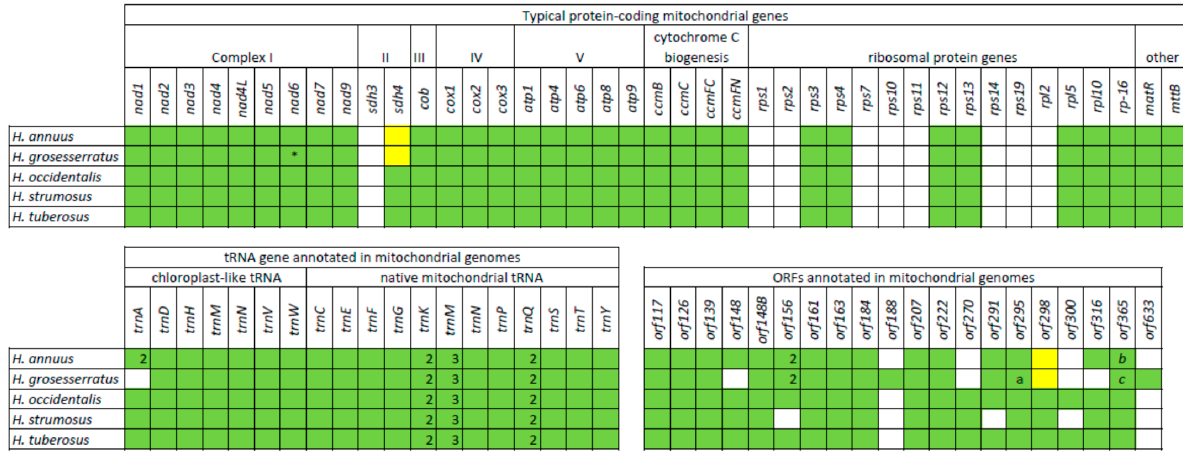
Figure 3. The distribution of protein-coding, tRNA genes, and ORFs among Helianthus species with complete mitogenomes. White square—the absence of the gene, green square—the presence of the gene, yellow square—the presence of pseudogene (premature stop codon). *, a, b, c = C–terminus shortening of the encoded proteins: a = orf216 , b = orf334 , c = orf284.